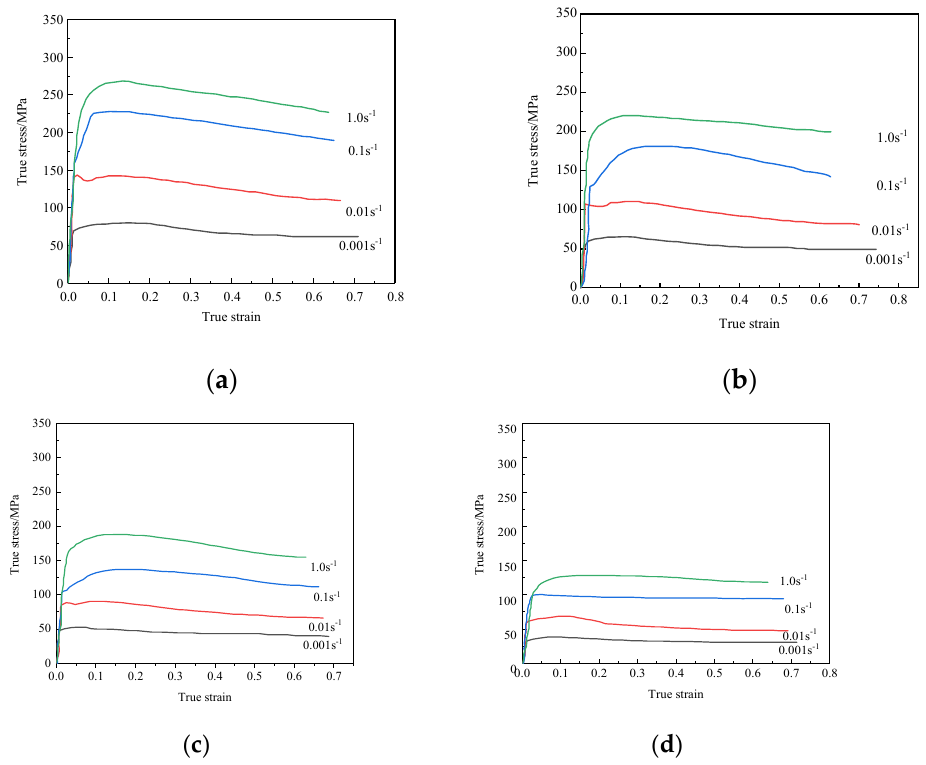
Figure 4. True stress – strain curves of GH901 ( a ) T = 990 °C ( b ) T = 1040 °C ( c ) T = 1090 °C ( d ) T = 1140 °C.